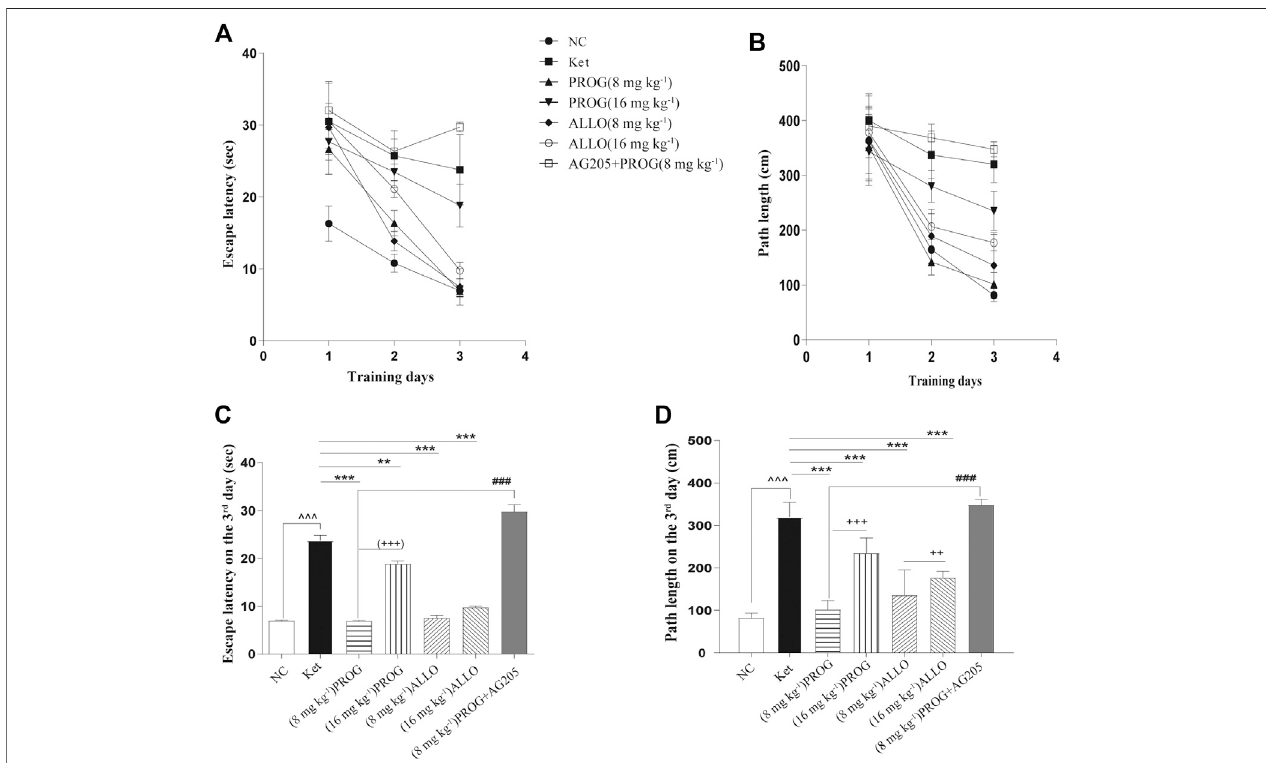
FIGURE 2 | Cognitive performance in the hidden platform trials of MWM test after add-on PROG and ALLO treatments. (A) Escape latency (B) Path length (C) Escape latency on the third day and (D) path lengths on the third day were shortened by PROG (all p < 0.01) or ALLO treatment (all p < 0.0001) in comparison with ketamine treatment. Dataare expressed asmean ± SD, n (cid:2) 7for each experimental group. * p < 0.05, ** p < 0.01 and *** p < 0.001 foradd-on ofPROGand ALLO vs. Ket. # p < 0.05, ## p < 0.01 and ### p < 0.001 for PROG (8 mg kg − 1 )+AG205 vs. PROG (8 mg kg − 1 ). + p < 0.05, ++ p < 0.01 and +++ p < 0.001 for PROG (16 mg kg − 1 ) vs. PROG (8 mg kg − 1 ) and ALLO (16 mg kg − 1 ) vs. ALLO (8 mg kg − 1